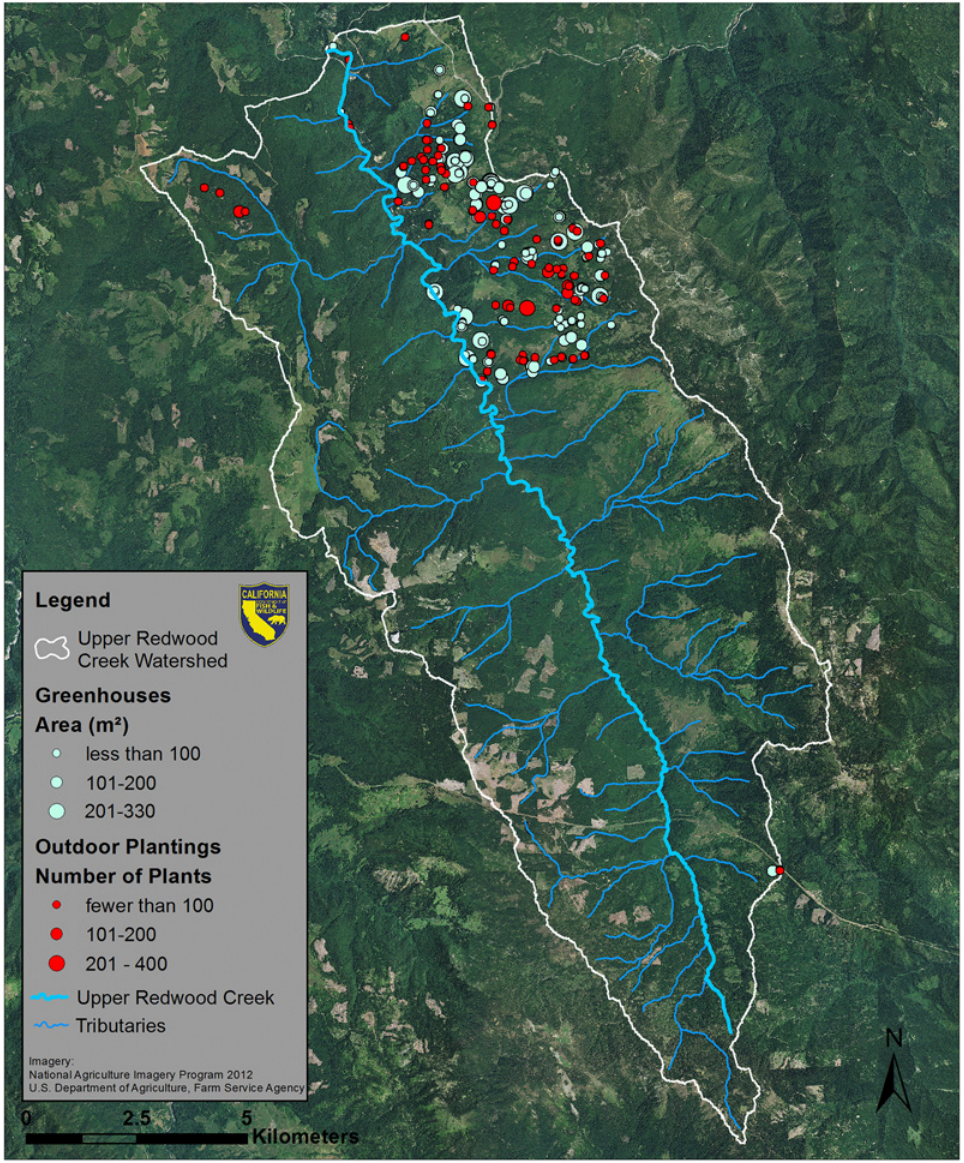
Fig 2. Upper Redwood Creek Watershed. Outdoor marijuana plantings are marked in red and greenhouses are marked in light green.